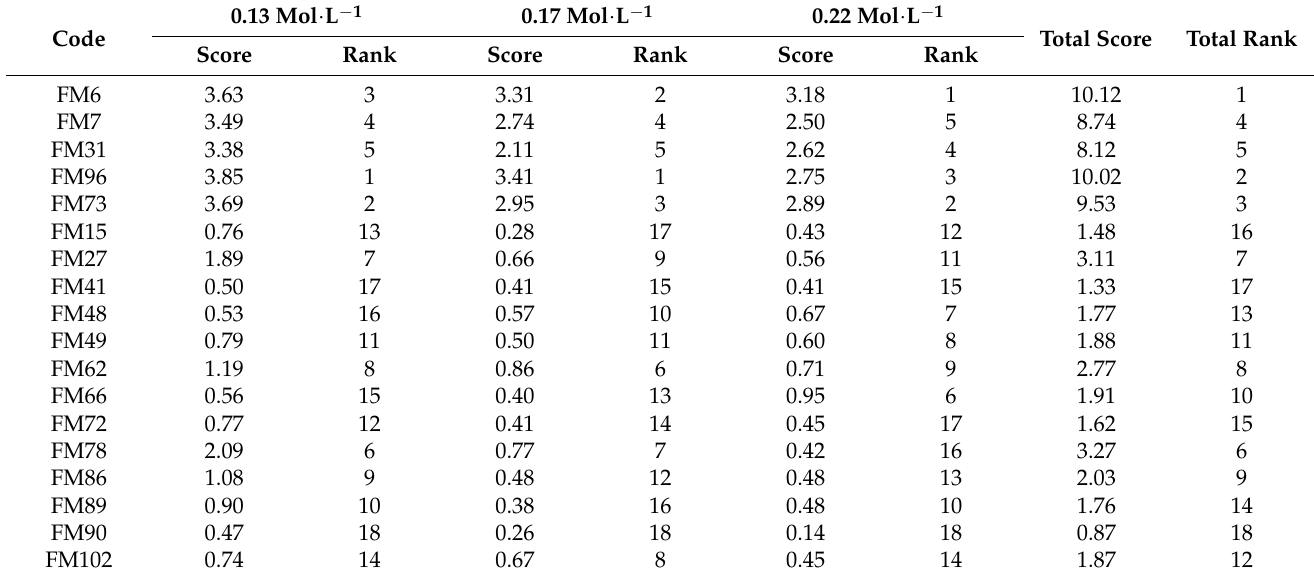
Table 1. Comprehensive evaluation of salt tolerance of 18 foxtail millet accessions in seeding foxtail millet under different NaCl concentrations. The score and rank under different NaCl concentra- tions indicate the scores and rank at that concentration, while the total score and rank indicate the comprehensive scores and rank under all NaCl